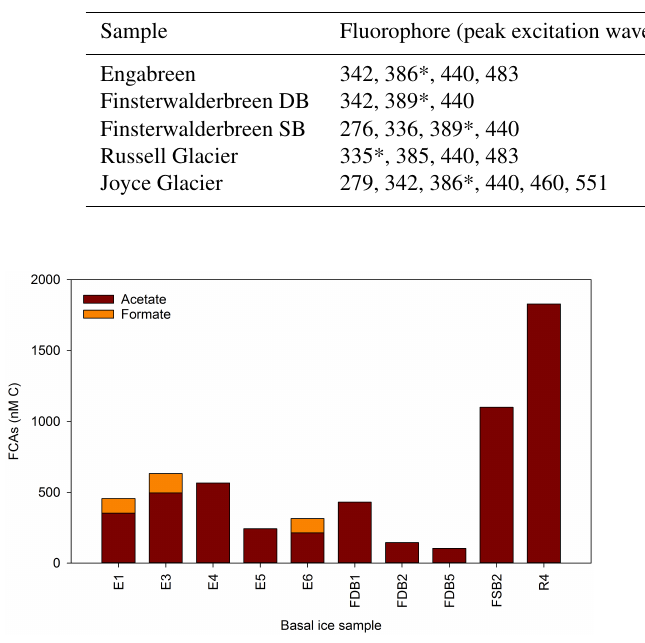
Figure 3. FCA compositions in basal ice samples. E – Engabreen, F – Finsterwalderbreen, R – Russell Glacier, DB – dispersed banded, SB – solid banded. Samples with zero concentrations have been ex- cluded from the plot, and only values >LOQ have been included.